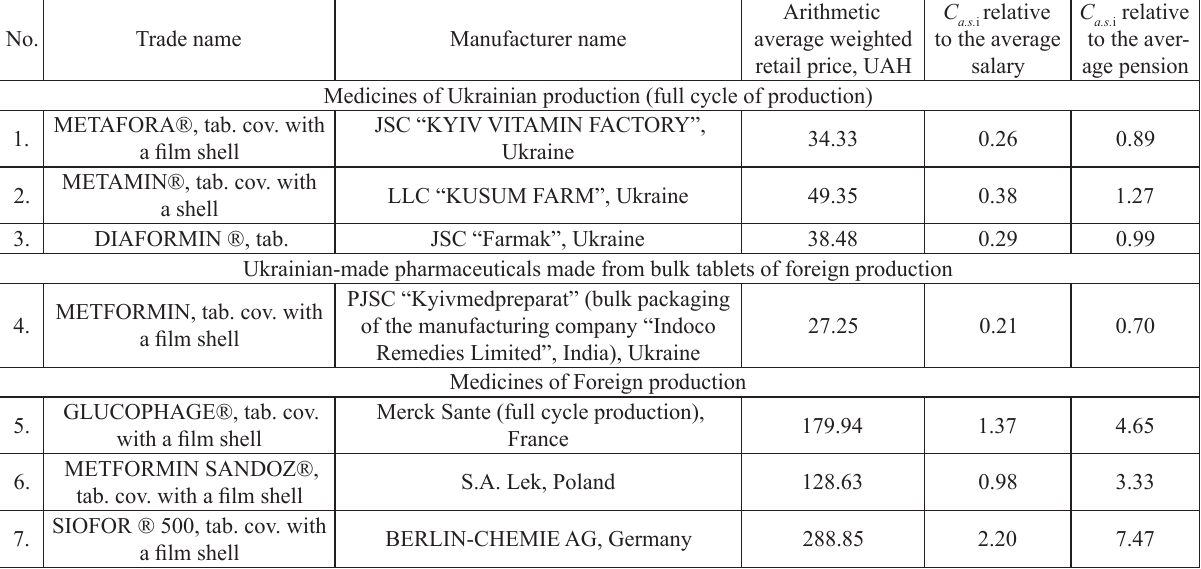
Results of calculation of the solvency adequacy ratio for able-bodied persons and persons of retirement